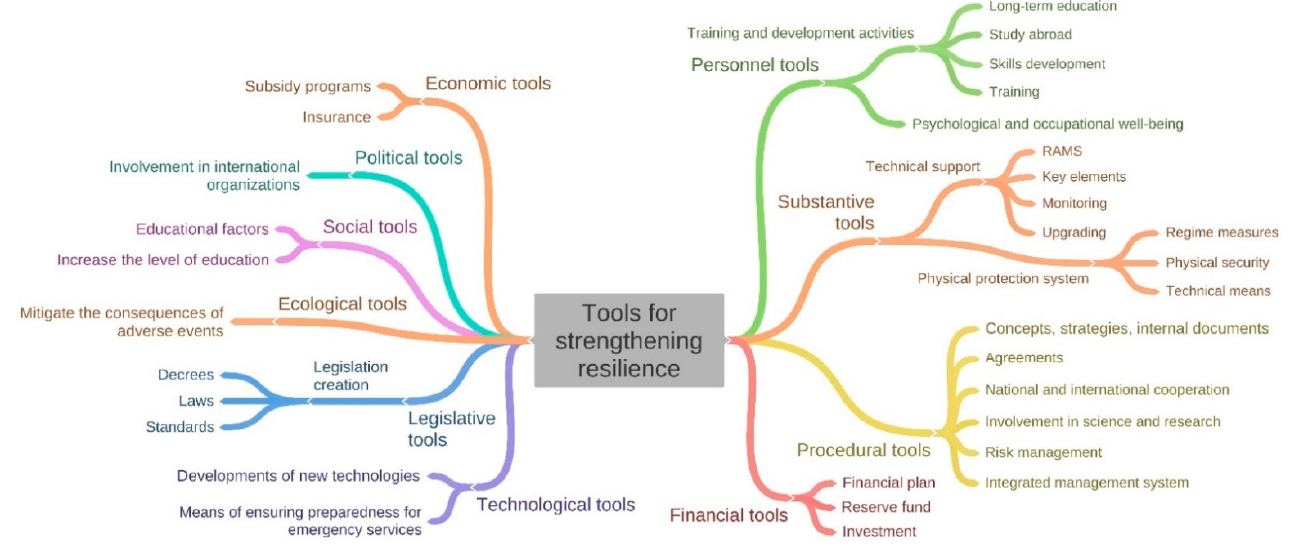
Figure 3. Tools for strengthening the resilience of critical energy infrastructure